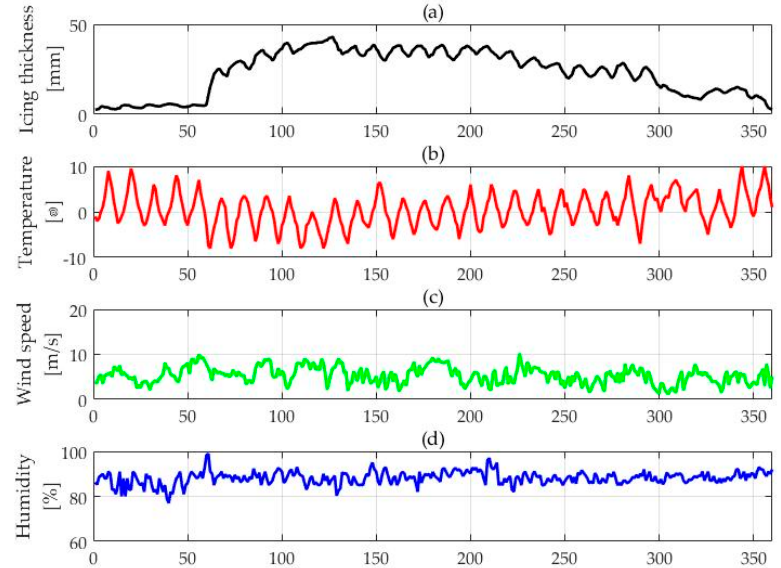
Figure 9. Original data chart of icing thickness, temperature, wind speed and humidity. Note: ( a ) represents the original data of icing thickness; ( b ) represents the original data of temperature; ( c ) represents the original data of wind speed; and ( d ) represents the original data of humidity.